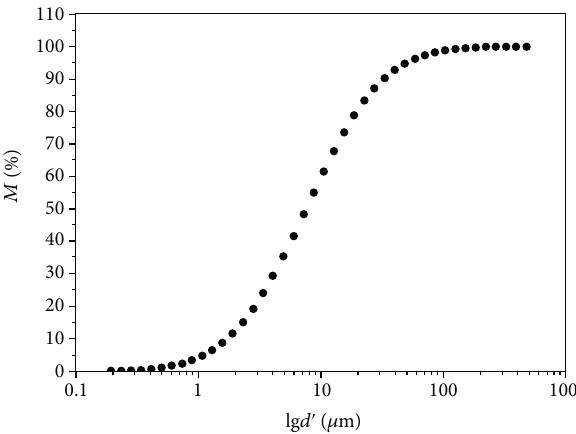
Figure 3: Particle diameter d and cumulative mass M curve.